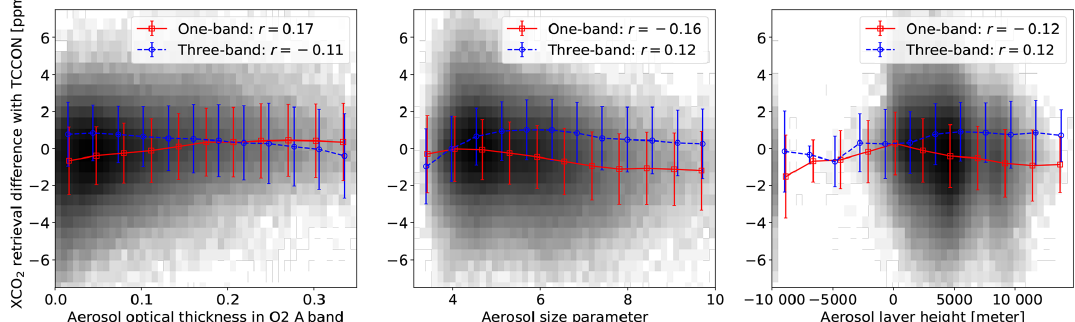
Figure 4. Error on X CO 2 from one-band and three-band OCO-2 land retrievals as a function of aerosol optical thickness (in O 2 A band), size parameter, and layer height as retrieved by three-band retrievals. Shown are the mean bias for each parameter bin along with standard deviation within each bin. Background includes the density map of X CO 2 errors from one-band retrievals.